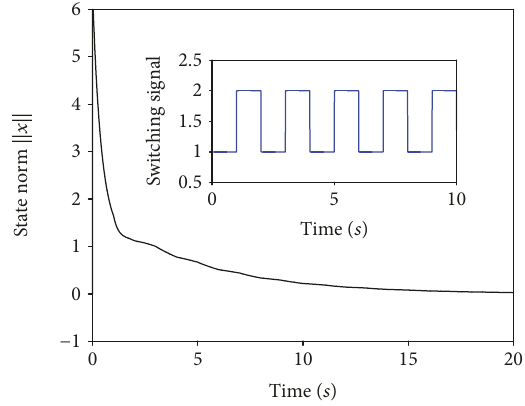
Figure 5: State norm response of the considered SNNs for Example 1 with switching signal. Table 1: Stability conditions are derived by di ff erent methods.